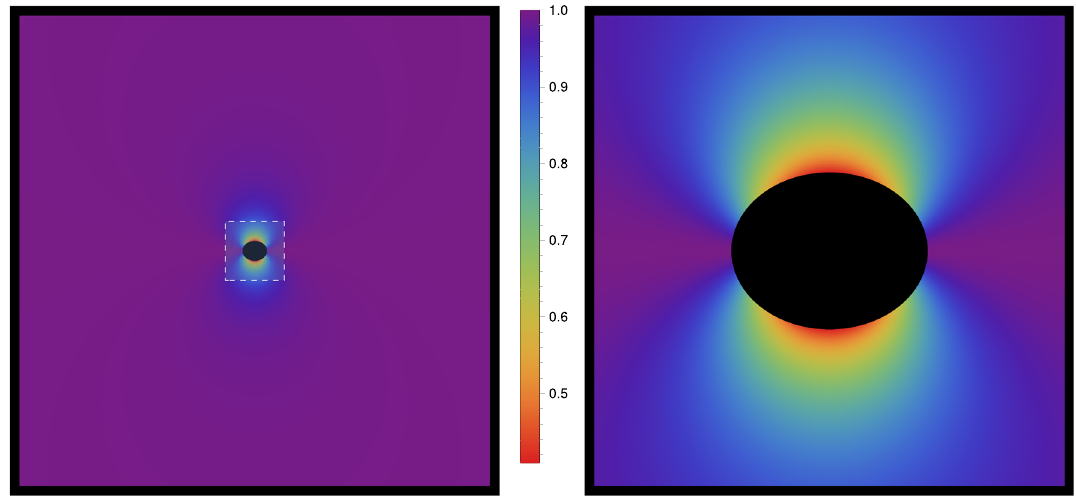
Fig. 1 Warped energy density (cid:6)( r ,θ) around black holes. We show the plane x = 0, where the black region represents a black hole with a ver- tical rotation axis. There is not warped energy in the equatorial plane,